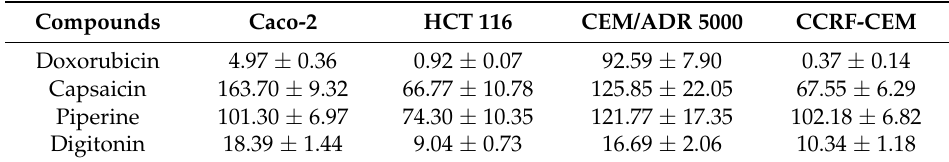
Table 1. The cytotoxicity of different compounds in resistant and sensitive cancer cells. The IC 50 values ( μ M) of capsaicin, piperine, and doxorubicin against different cell lines are presented as the mean ± SD.